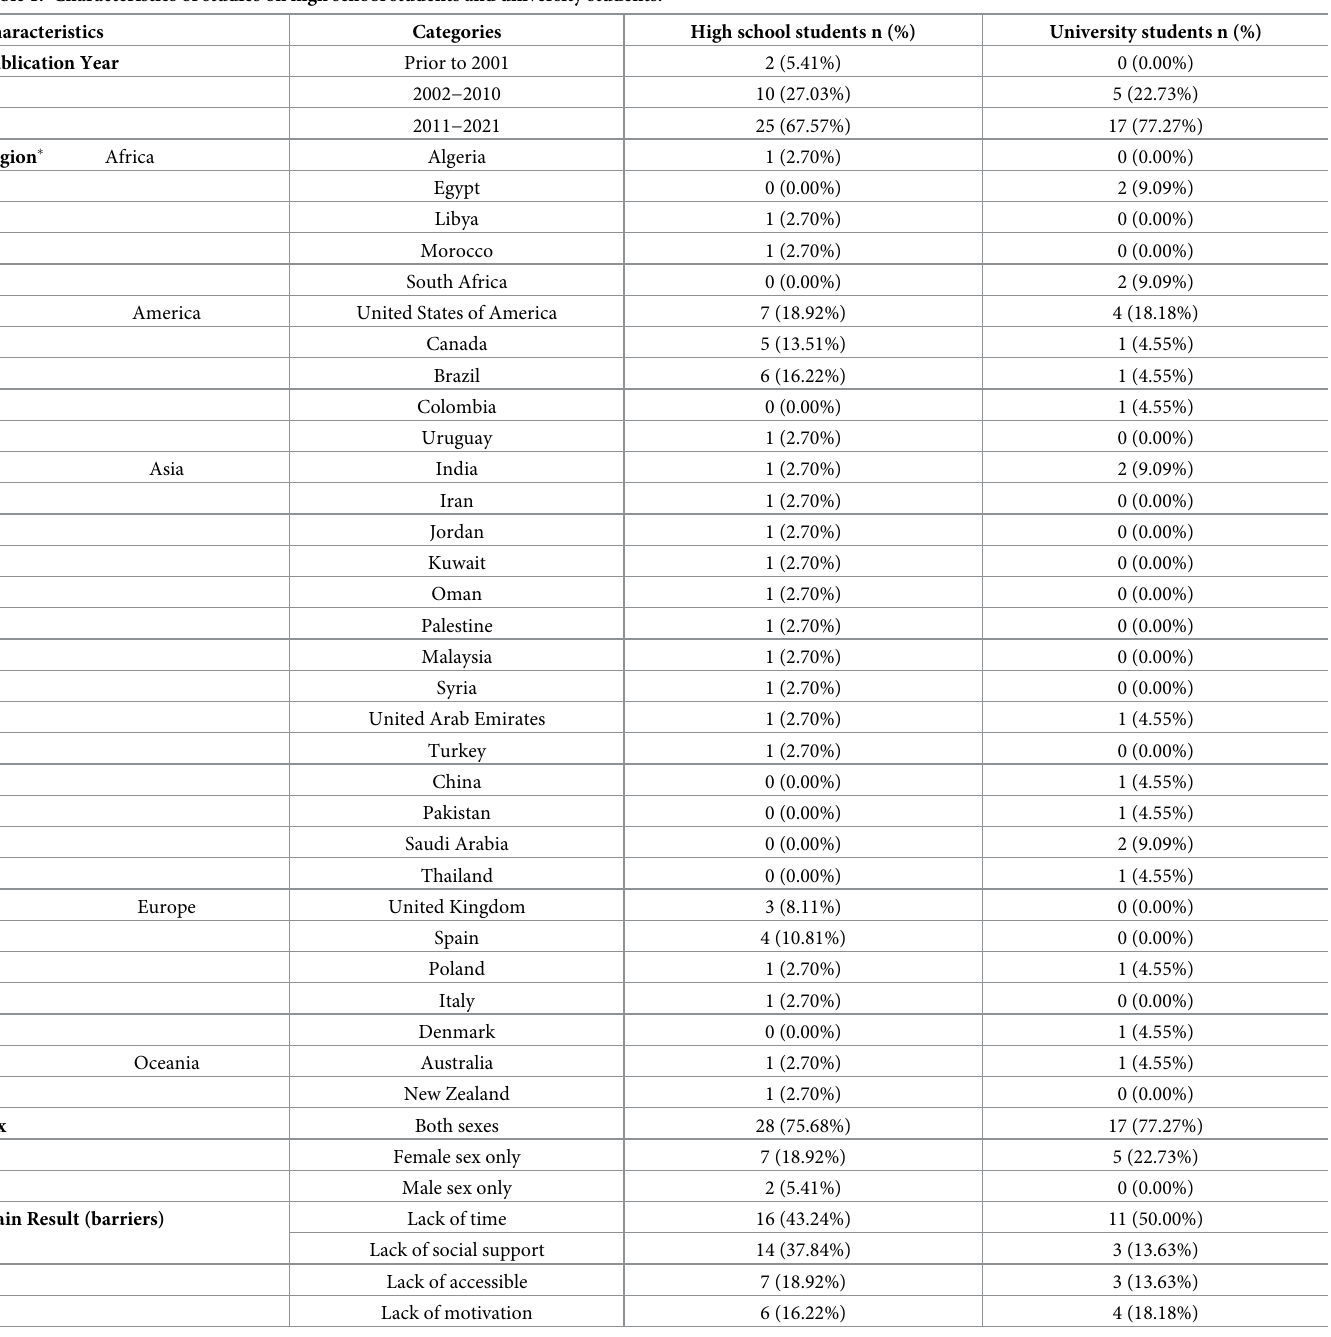
Table 1. Characteristics of studies on high school students and university students.